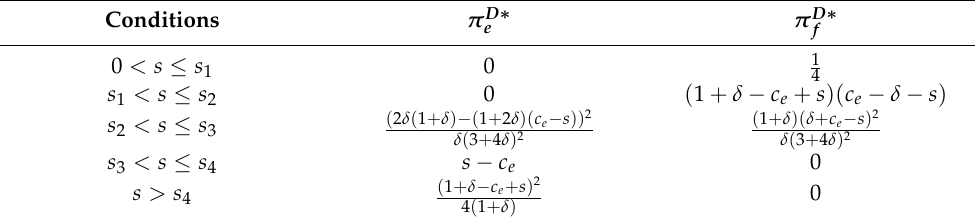
Table 7. Equilibrium profit under the demand subsidy